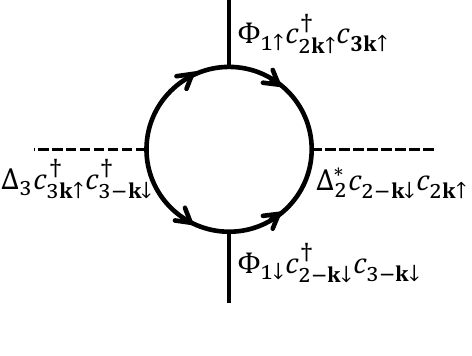
Figure 4: The diagrammatic representation for u